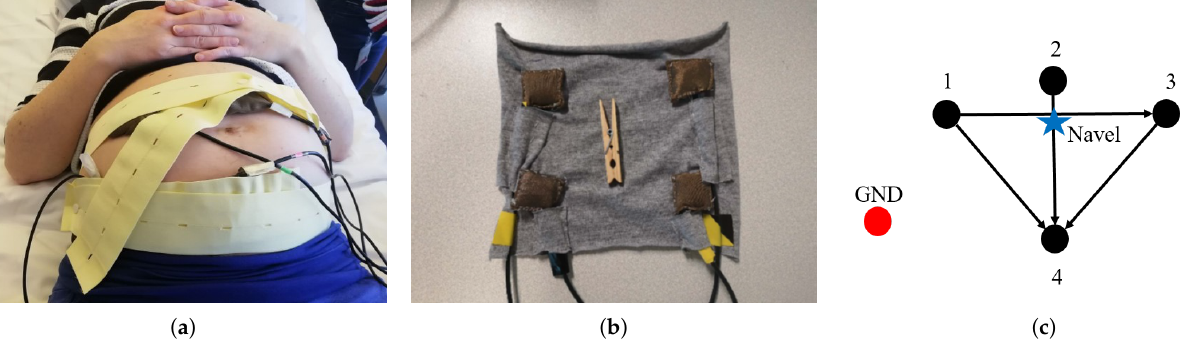
Figure 1. Features of the employed acquisition system. ( a ) Placement of electrodes by means of elastic belts on the mother’s belly. ( b ) Four textile electrodes. ( c ) Schematic configuration of the electrodes and the related bipolar leads, which are identified by arrows. The configuration is symmetric with respect to the